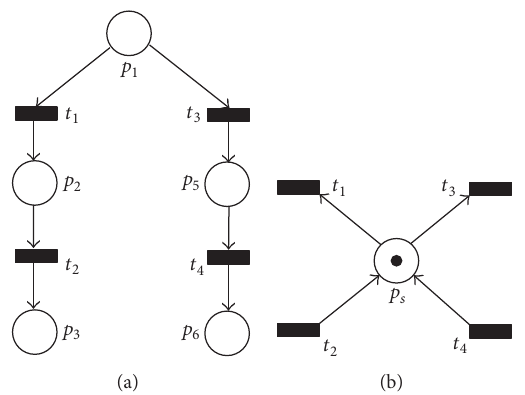
Figure 3: (a) A plant and (b) the corresponding supervisor obtained by generalized mutual exclusion constraints.